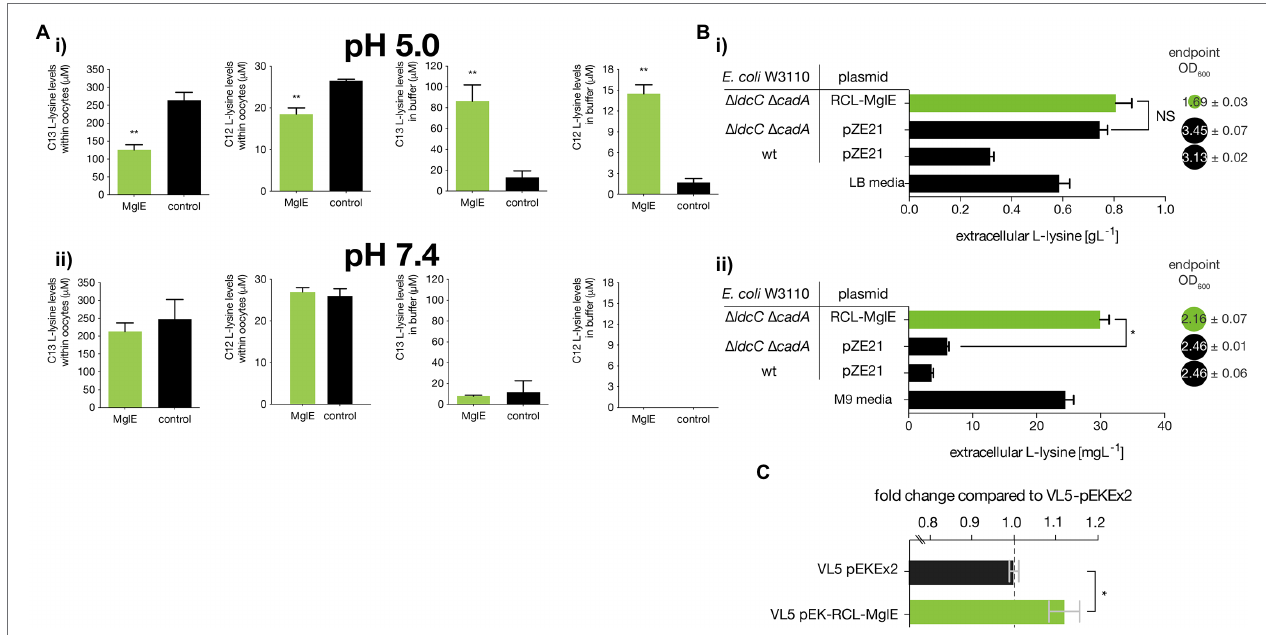
FIGURE 3 | Functional characterization of MglE transporter activity in Xenopus oocytes, E.coli and Corynebacterium glutamicum . (A) L-lysine export assay of MglE transporter in Xenopus oocytes in Kulori buffer (i) at pH 5 and (ii) at pH 7.4. The bars represent lysine contents in the oocytes or the buffer (means ± SD, 3–4 biological replicates each involving 20 oocytes). Significant changes are in comparison with the controls marked by asterisks (** p < 0.01; Fishers one-way ANOVA). (B) The extracellular L-lysine concentration of reference E. coli W3110 and its isogenic mutant strain DMLC along with the cell OD 600nm values confirming the exporter activity of the MglE protein in (i) LB media and (ii) in M9 minimal media supplemented with yeast extract (* p < 0.0001, t -test). (C) Fold enhancement of specific production of L-lysine by MglE protein in the industrial C. glutamicum VL5 strain compared to the empty vector control. Error bars are s.e.m., * denotes p = 0.023, n =